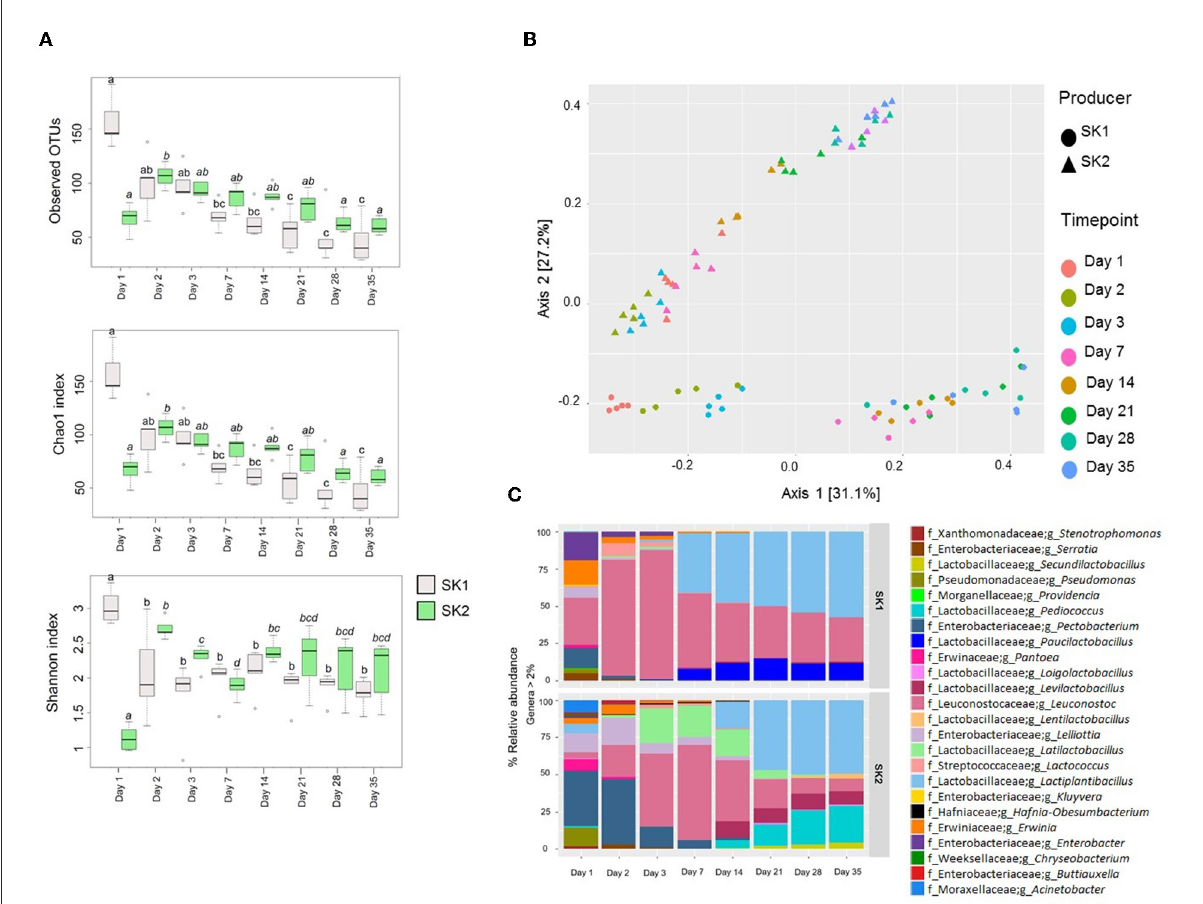
FIGURE2 Metataxonomic analysis of sauerkraut fermentation brine. (A) Bacterial α -diversity using observed OTUs, Chao1, and Shannon index from day 1 to day 35 of sauerkraut fermentation from both producers (SK1 and SK2). The line inside the box represents the median, and the whiskers from either side of the box represent the first and the third quartiles, respectively. ◦ = outliers. Different superscript letters indicate statistical significance within the same producer. (B) Principal component analysis (PCoA) representing the bacterial β -diversity according to Bray–Curtis dissimilarity index. Different colors and shapes indicate different time points and producers, respectively, as described in the legend. (C) Mean percentage relative abundance of the most abundant genera ( > 2%) at days 1, 2, 3, 7, 14, 21, and 35 of fermentation ( n = 5